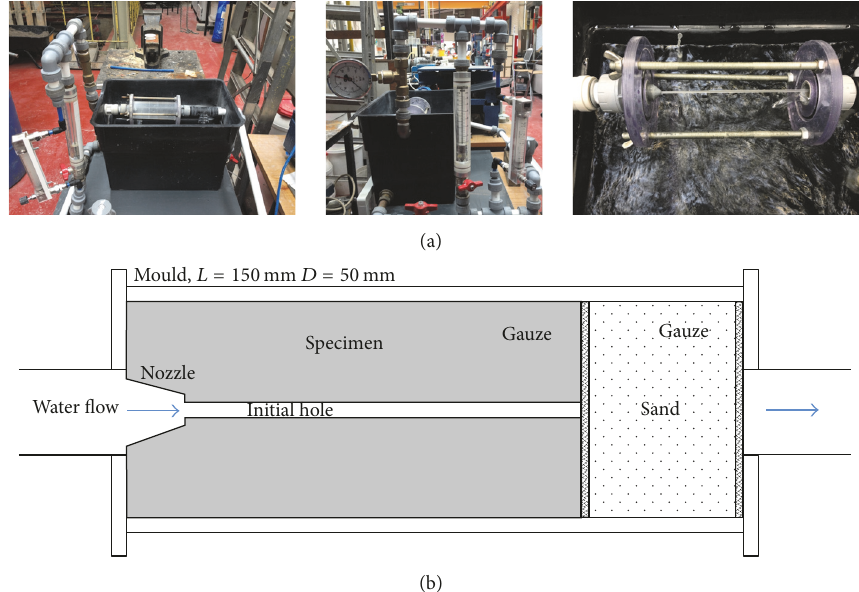
Figure 1: (a) Internal erosion apparatus (left); measurements of water flow and pressure (middle); the controlled water jet (right); (b) detailed erosion device setup